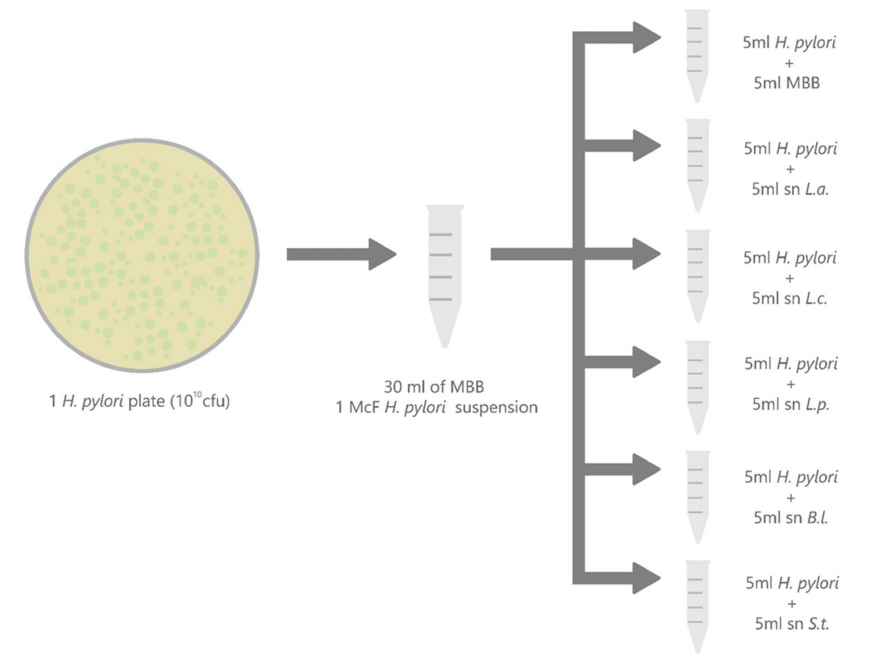
Figure 6. Aliquots of H. pylori suspension co-incubated with supernatants (sn) of probiotic strains (1:2 v / v ). CFU: colony forming unit. MBB: modified brucella broth. L.a.: L. acidophilus . L.c.: L. casei . L.p.: l. paracasei . B.l.: B. lactis . S.t.: S. thermophilus